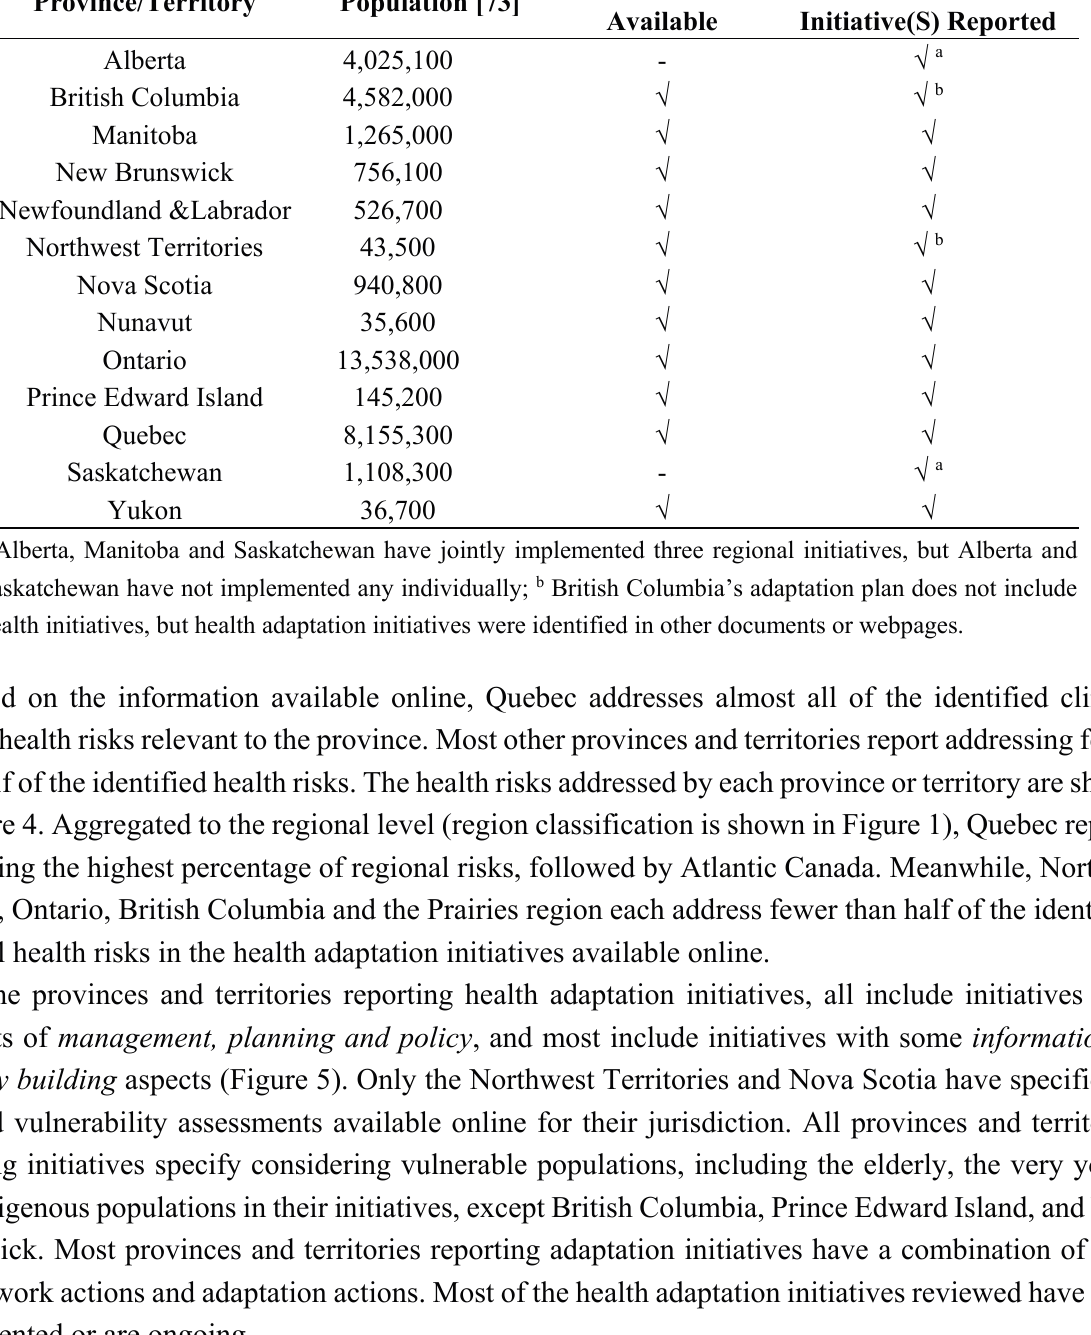
Table 3. Population size, adaptation plans and health initiatives in Canadian provinces and territories. Province/Territory Population